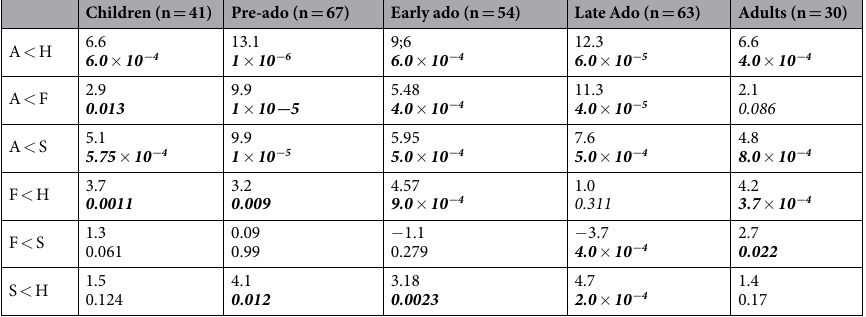
Table 2. Comparisons of performance for pairs of emotions in four different age groups. Each cell indicates the t- value for the post-hoc comparison between pairs of emotion and, underneath, the corresponding p- value (Holm-Bonferoni correction), in BOLD if < 0.05. A: Anger; H: Happiness; F: Fear; S: